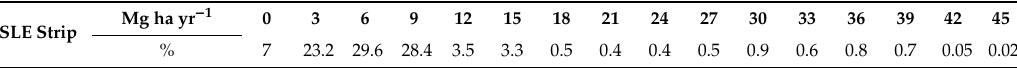
Table 3. Soil mobilisation rates per pixel type using RUSLE (Revised Universal Soil Loss